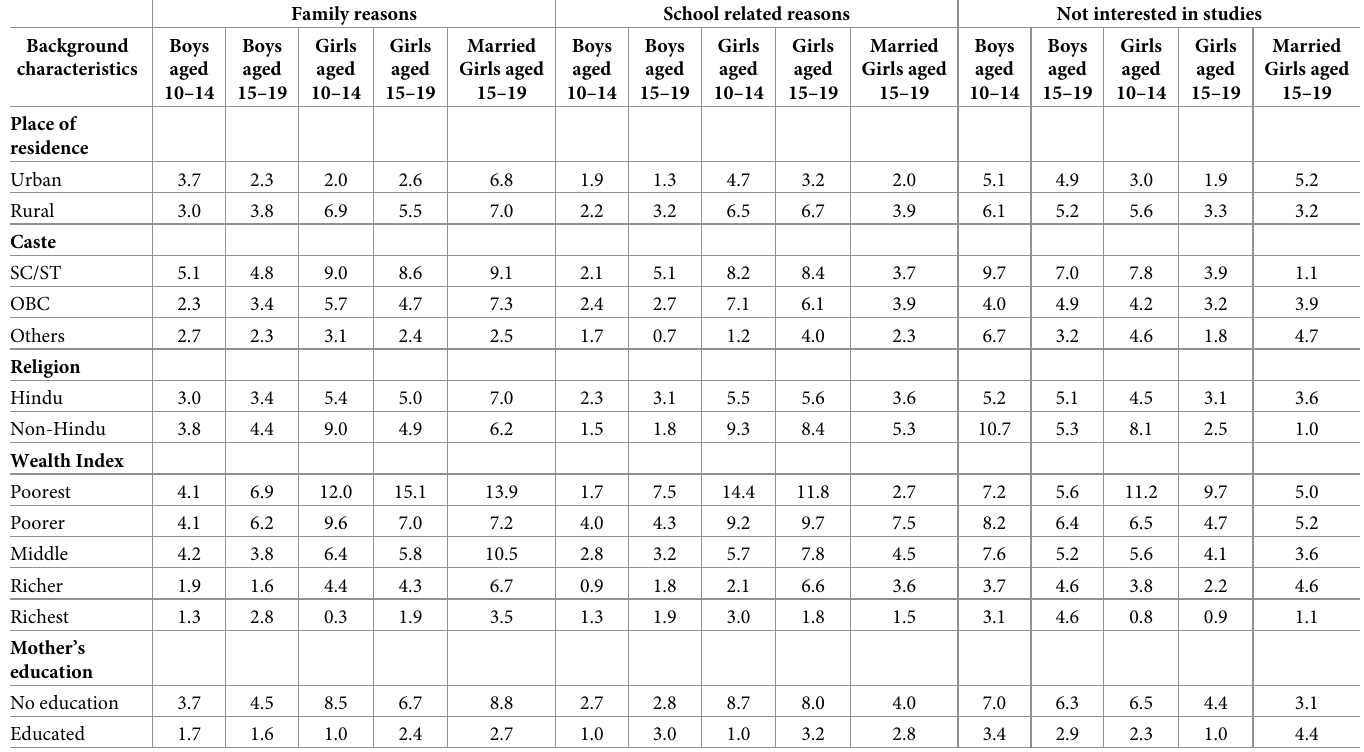
Table 5. Reasons for dropouts among adolescents by socio-demographic and economic characteristics, 2018–19. Family